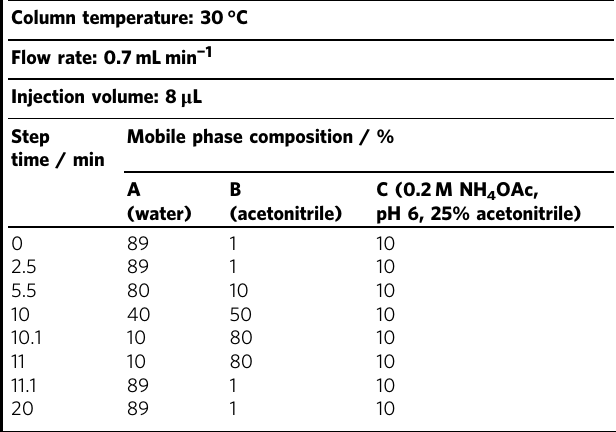
Table 2 HPLC conditions for analysis of digested